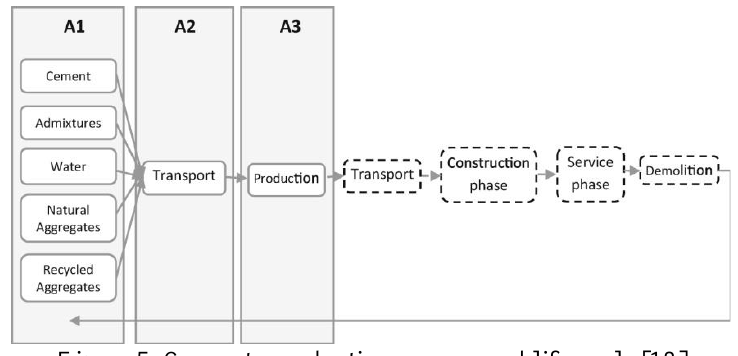
Figure 5. Concrete production process and life cycle